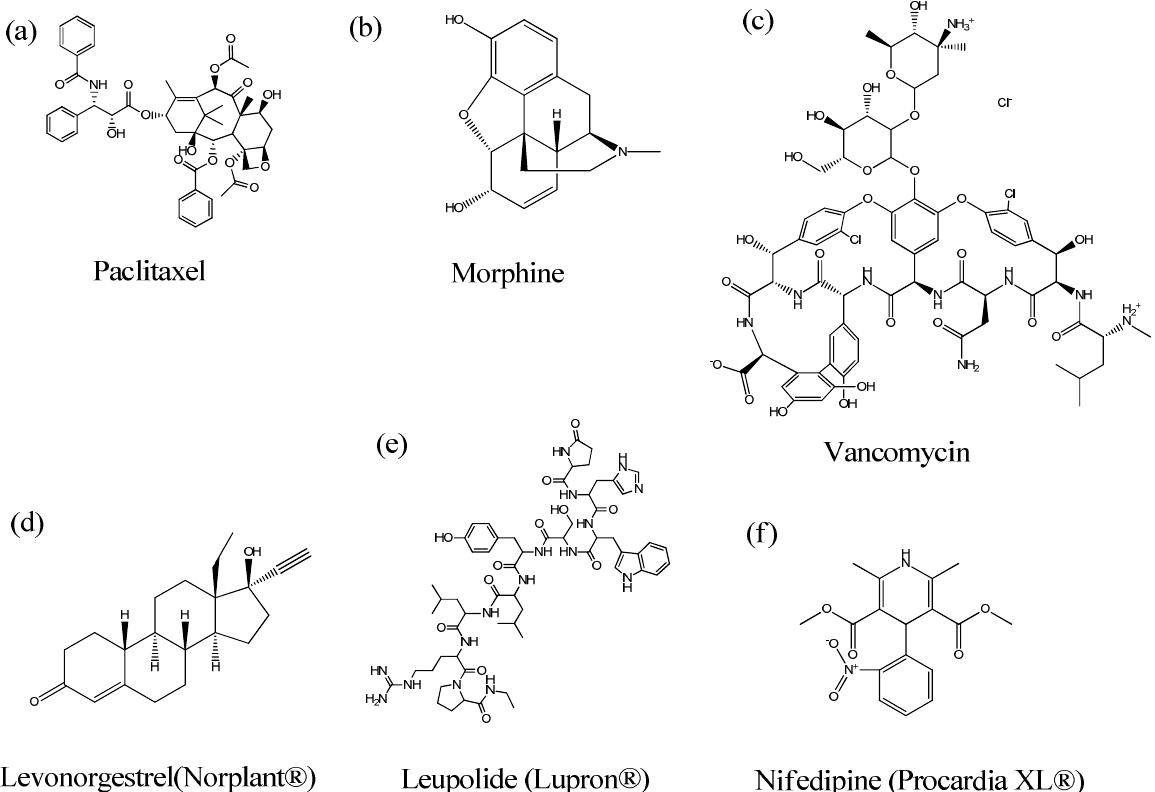
Figure 2. Various therapeutic agents from different therapeutic classes that have been encapsulated in polymeric